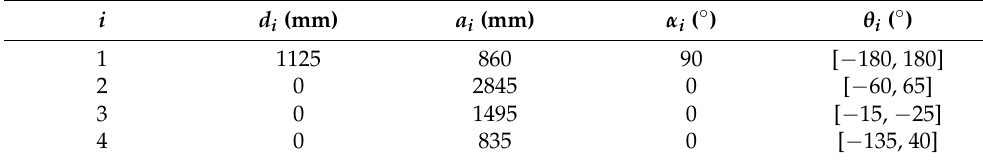
Figure 6. Scene of manual excavation and autonomous excavation. The number in figure represents the engine speed sets at 1800 rpm. ( a ) Manual excavation; ( b ) Autonomous excavation. Table 1. D–H parameters of SWE50 excavator.